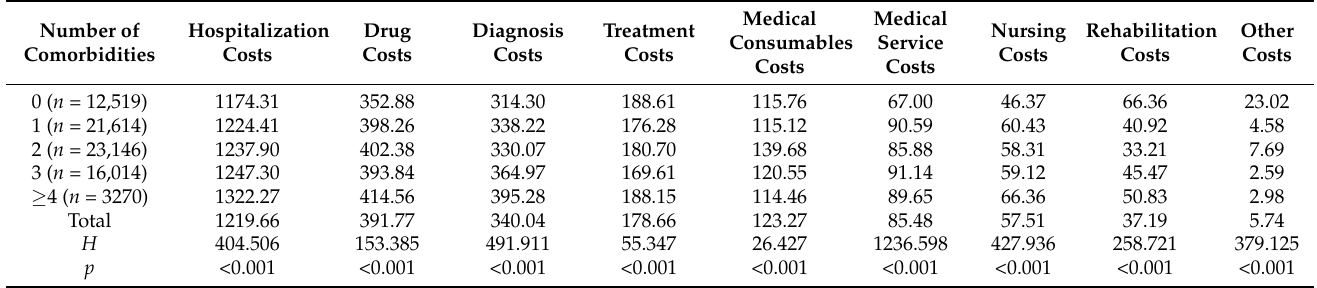
Table 2. The status of costs in different numbers of comorbidities for cerebral infarction patients (US $).